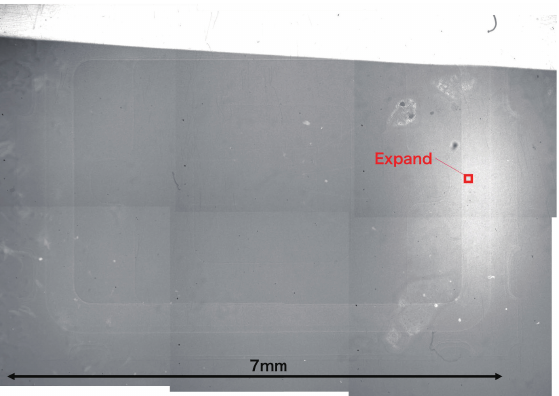
Figure 7. Transmission image of the quartz crystal oscillator taken using the emulsion detector. The area enclosed by the red square is enlarged and shown in Figure 8.